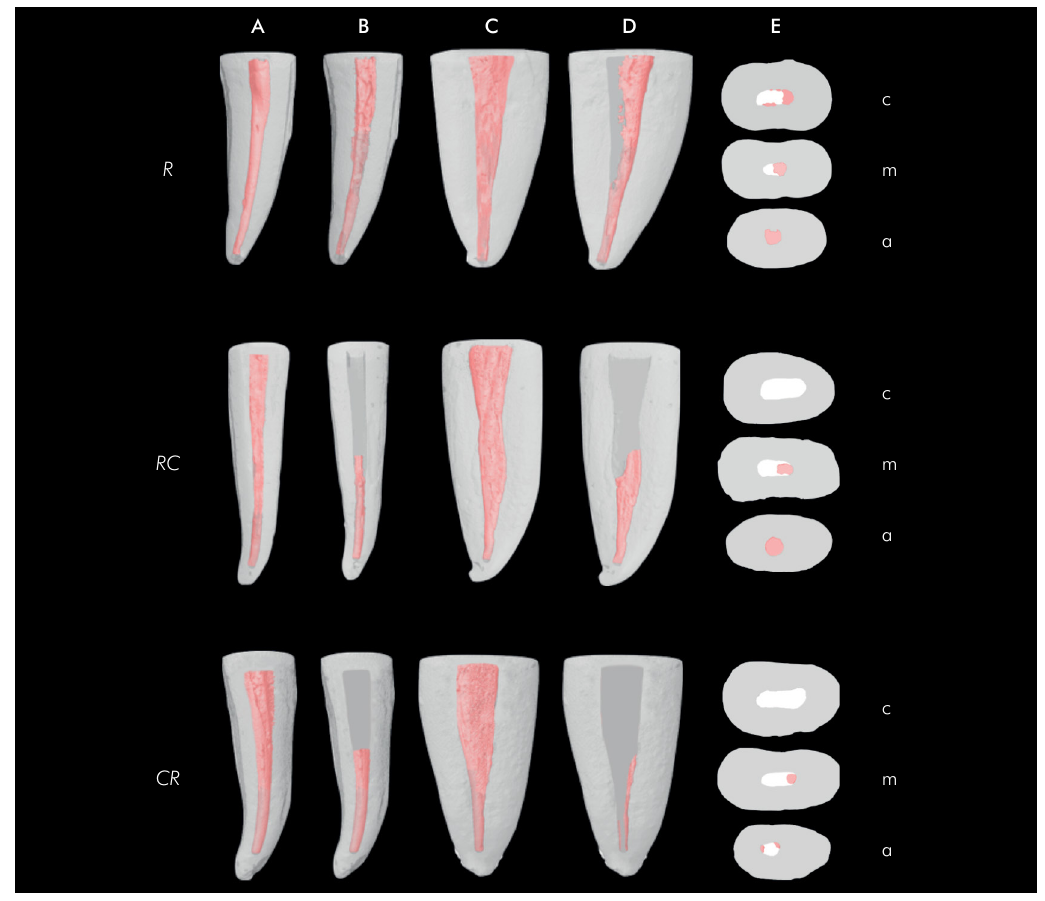
Figure 2. Representative reconstructions of the superimposed specimens before (A and C) and after (B and D) removing the filling material in each experimental group. Front (A and B) and side views (C and D). Representative cross-sections of the superimposed flattened/oval-shaped mandibular incisors (E) after removing the filling material in each experimental group at the coronal (c), middle (m), and apical (a)